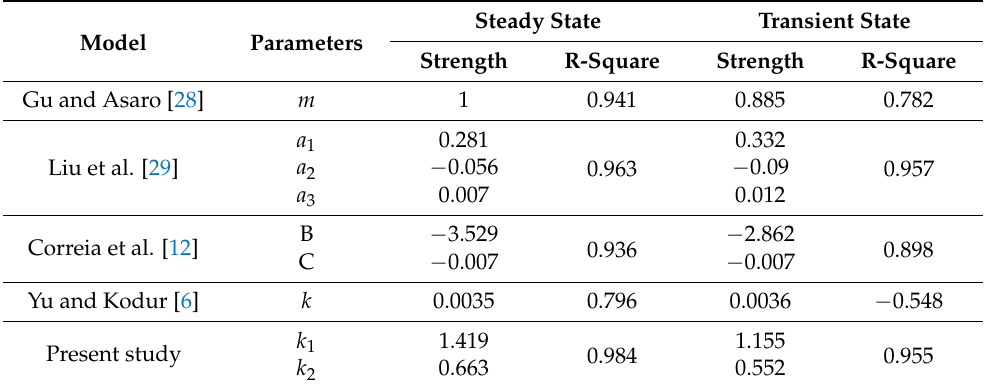
Table 5. Simulation of CFRP material strength for different